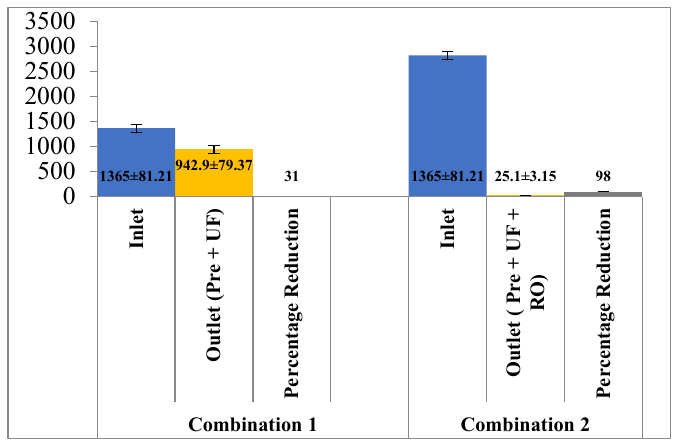
Figure 9. Effect of different treatment setups on the lignin removal .